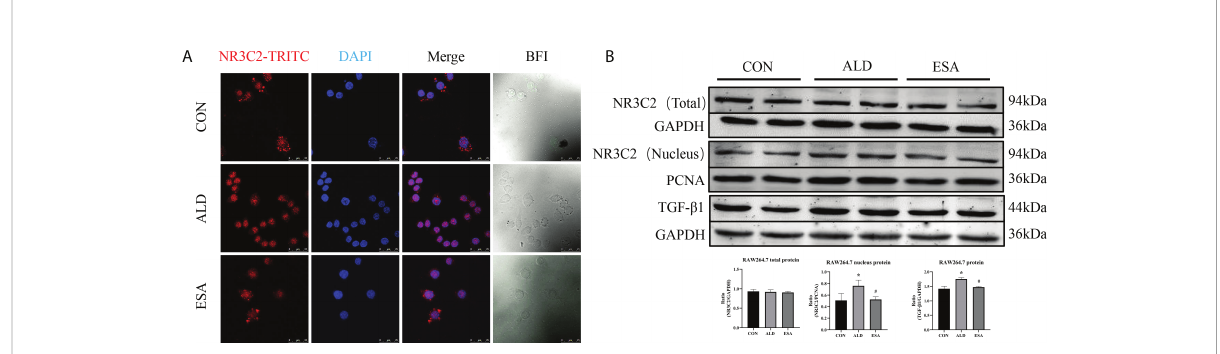
FIGURE 6 Effects of ALD and ESA on the expression of MR and its downstream molecule TGF- b 1. (A) Immuno fl uorescence staining of kidney sections with antibodies against the MR marker NR3C2 (red) and DAPI (blue) to examine the nuclear translocation of MR. (B) Western blotting analysis of MR in total and nuclear protein fractions and its downstream molecule TGF- b 1 in the total protein of RAW264.7 cells. The data are presented as the mean ± SD (n = 6), *p < 0.05 vs. the CON group, # p < 0.05 vs. the ALD group. ALD, aldosterone; ESA, esaxerenone; MR, mineralocorticoid